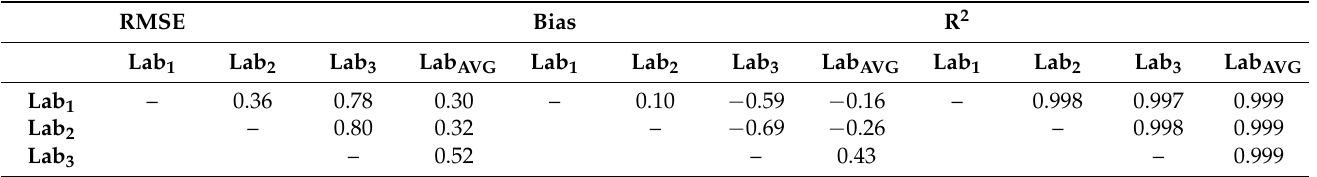
Table 3. Comparison of agreement between SOC measurements (g · kg − 1 ) from three different lab- oratories and their average ( n = 75); bias refers to the mean difference between row and column measurement series.